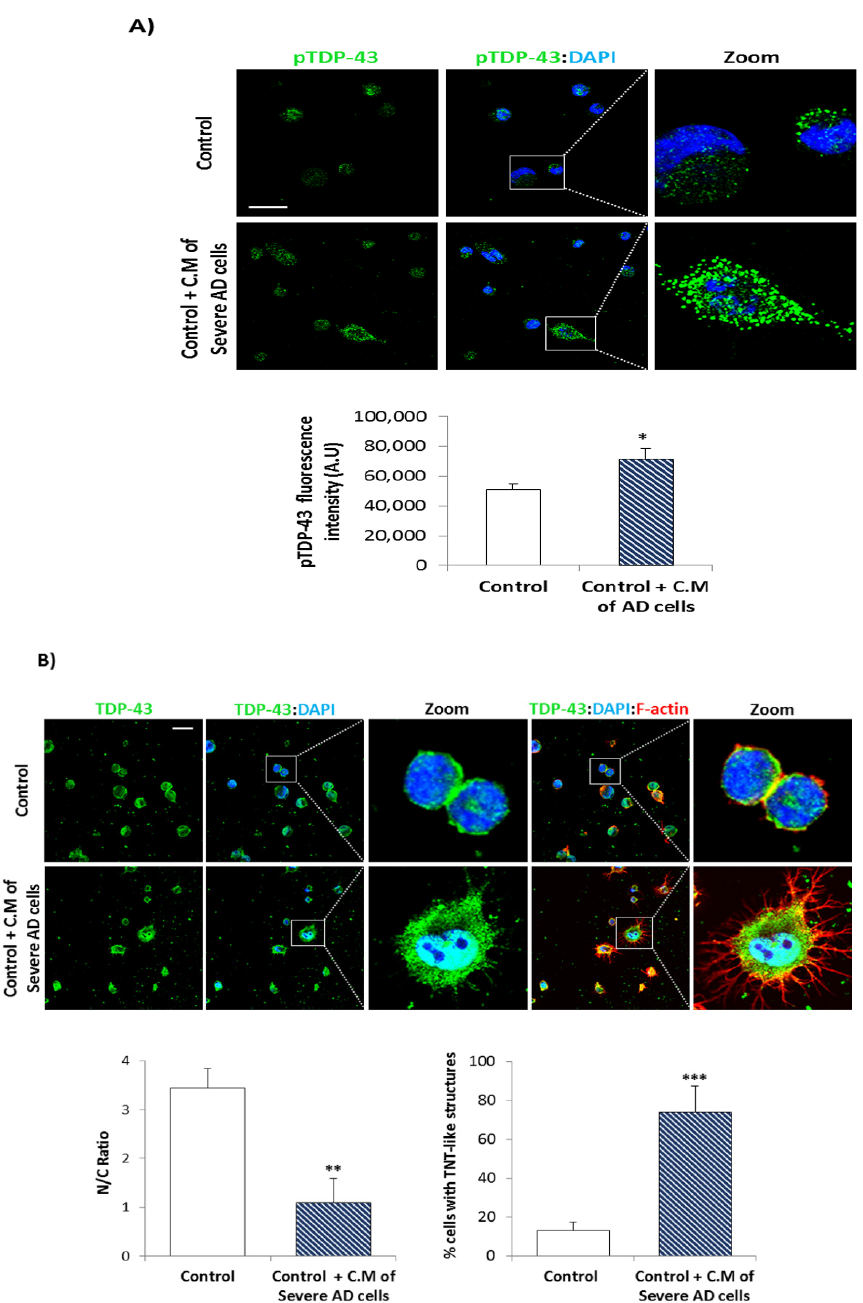
Figure 5. Conditioned medium (CM) of AD lymphoblasts induces TDP-43 pathology in control cells. ( A ) Immuno- fluorescence of pTDP-43 (green) and DAPI staining (blue) in control lymphoblasts cultured with CM of severe AD cells for 72 h versus untreated control cells. Fluorescence quantification was performed using Image J software in at least 4 fields of view. ( B ) Confocal immunofluorescence images of TDP-43 (green), F-actin (red) and DAPI staining (blue) in control lymphoblasts cultured in presence or absence of CM of severe AD cells for 72 h. Nucleo-cytoplasm ratio (mean nuclear intensity divided by the mean cytoplasmic intensity) and% of cells with F-actin protrusions (TNT-like structures) were measured in at least 4 fields of view using Image J software. (A.U, arbitrary units). Scale bars, 20 µm. Bars are the mean ± SD of three independent experiments Statistical analysis was performed using the Student t test. (* p < 0.05, ** p < 0.01, *** p < 0.001). Furthermore, CM from AD lymphoblasts induces also TDP-43 pathological changes, mislocalization and generation of TDP-43 aggregates in osteosarcoma U2OS cell line (Figure